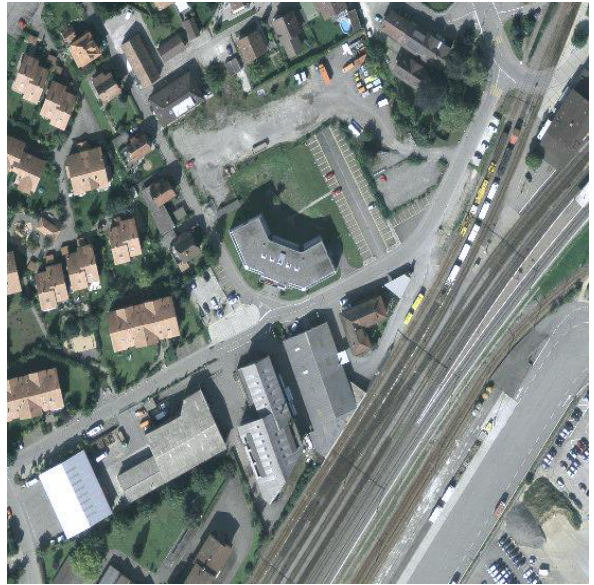
Figure 3. Orthophoto of the residential neighbourhood of Oensingen, (© swisstopo,